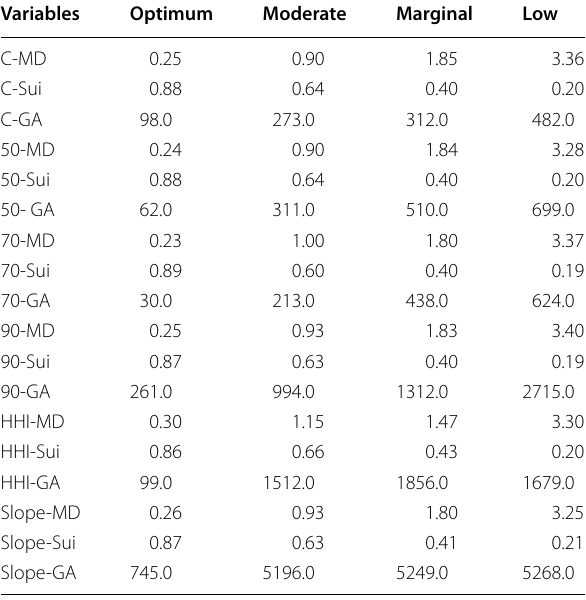
Table 5 Values of ecological niche modelling attributes classified under four habitat suitability classes of C.